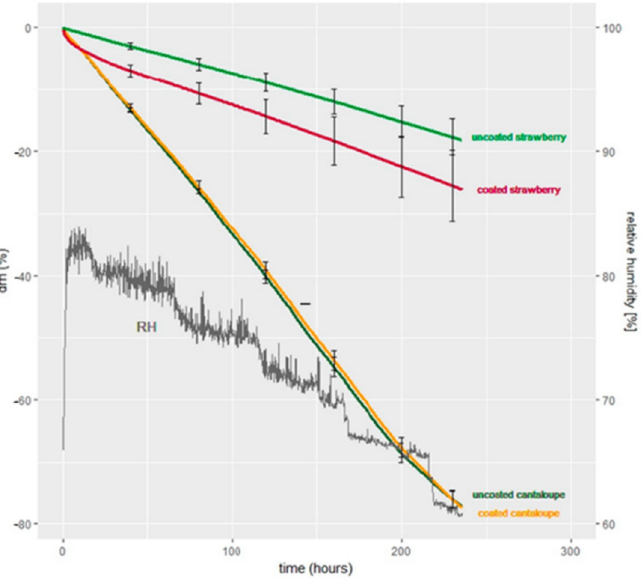
Figure 4. The relationship between the time and mass loss (%) of coated and uncoated strawberries and fresh-cut cantaloupes at 10 °C [65].